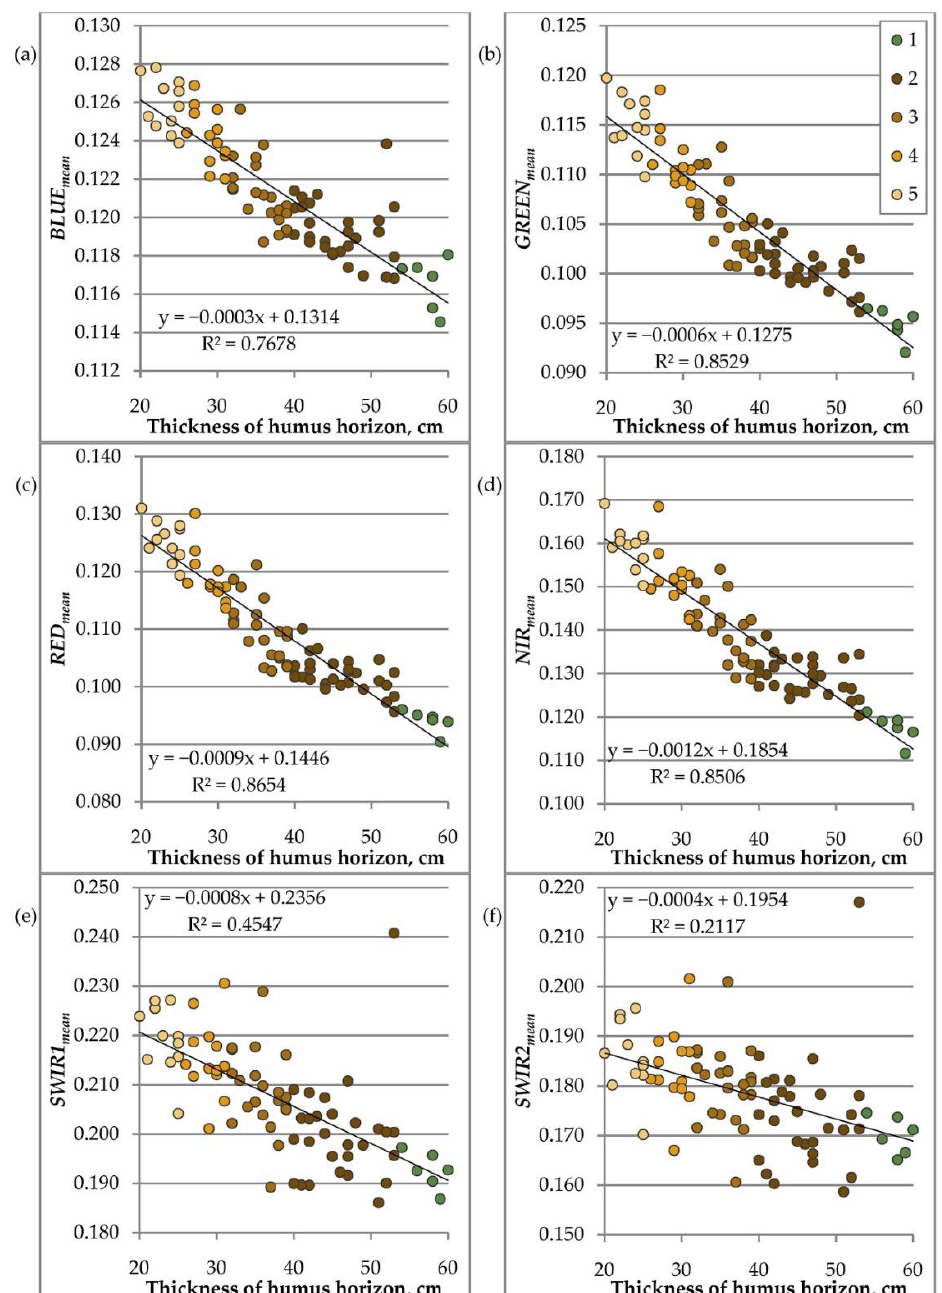
Figure 7. Correlation of BAND mean values and the thickness of the humus horizon (soils are: 1 — meadow-chestnut, 2 — dark chestnut, 3 — dark chestnut slightly eroded, 4 — dark chestnut medium eroded, 5 — dark chestnut strongly eroded).